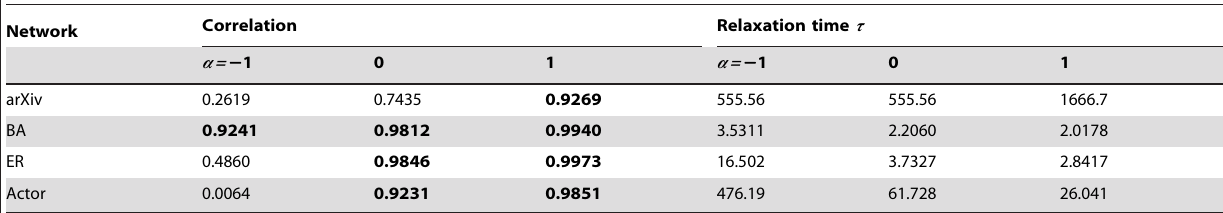
Table 2. Pearson’s correlation coefficient for